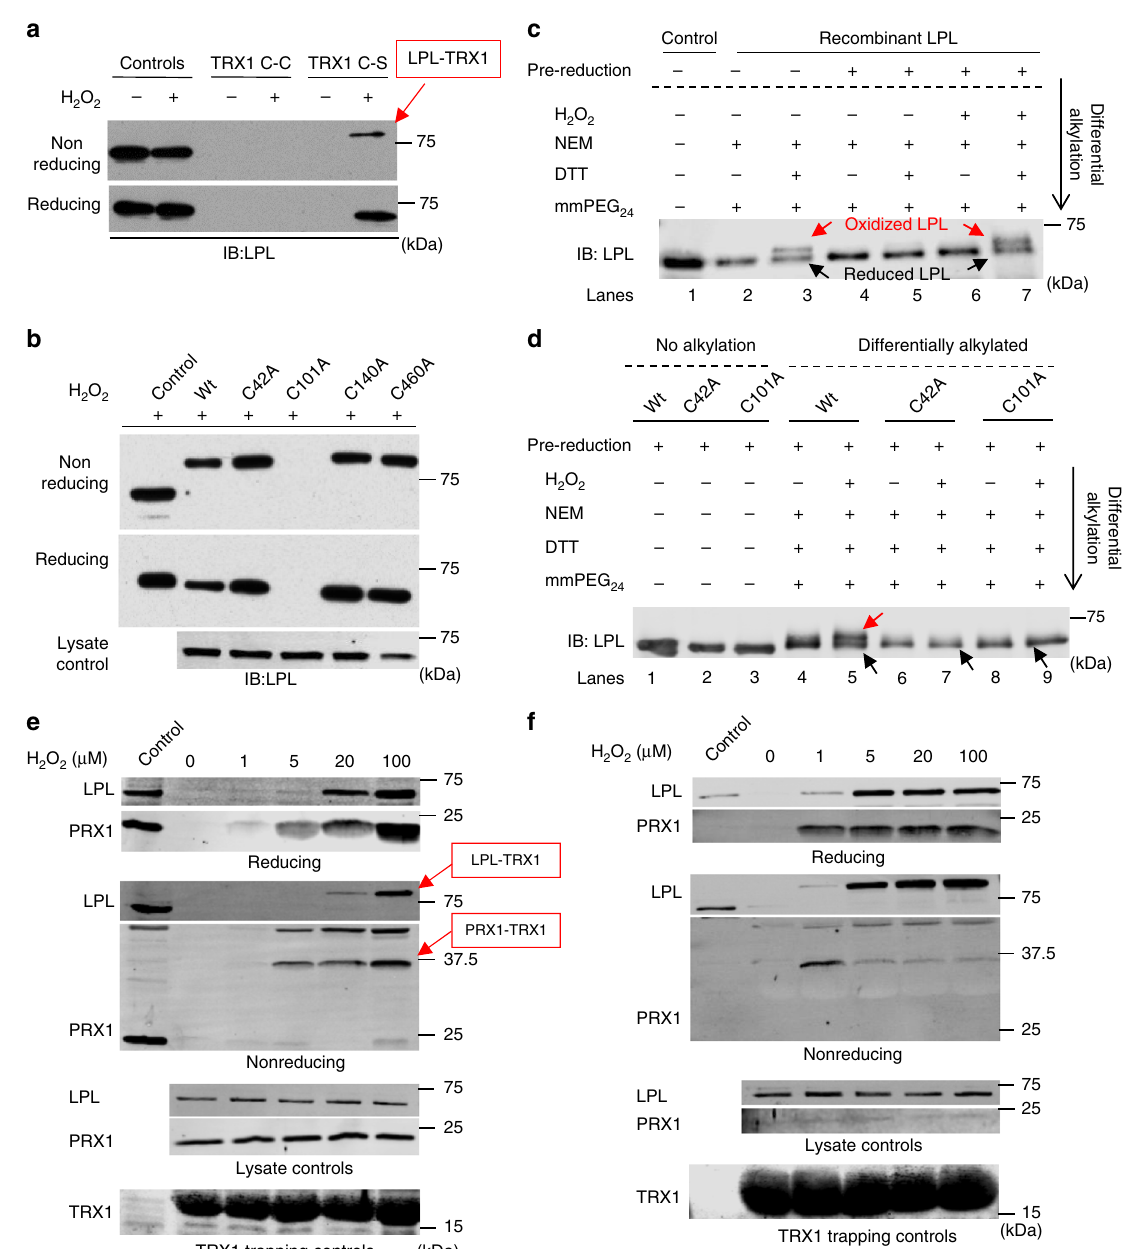
Fig. 2 TRX1 trapping and differential alkylation of LPL Cys-Ala mutants . a Representative immunoblots (IB) showing trapping of LPL by TRX1 C35S upon H 2 O 2 treatment. PC3 cells were kept untreated or were treated with 0.1 mM H 2 O 2 . Thereafter, the cells were lyzed, and the trapping reaction was performed using TRX1 C35S (the trapping mutant) or TRX1 C35C (wt). TRX1-bound complexes were puri fi ed by streptavidin af fi nity puri fi cation and analyzed by